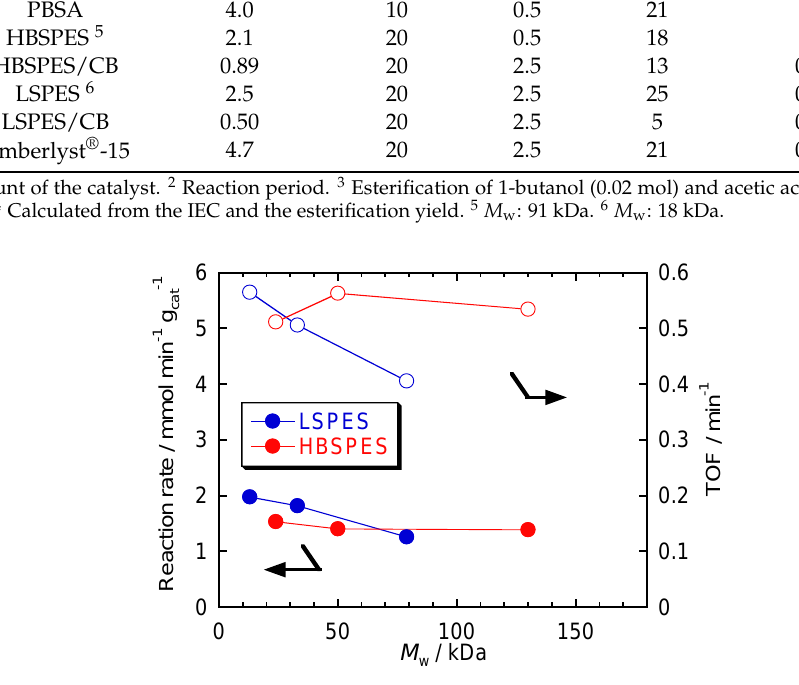
Figure 3. Normalized reaction rates and apparent turnover frequencies of homogeneous catalytic reactions for the esterification of 1-butanol (32 mmol) and acetic acid (1.8 mmol) at 65 °C for 0.5 h with various molecular weights of LSPES and HBSPES [10].